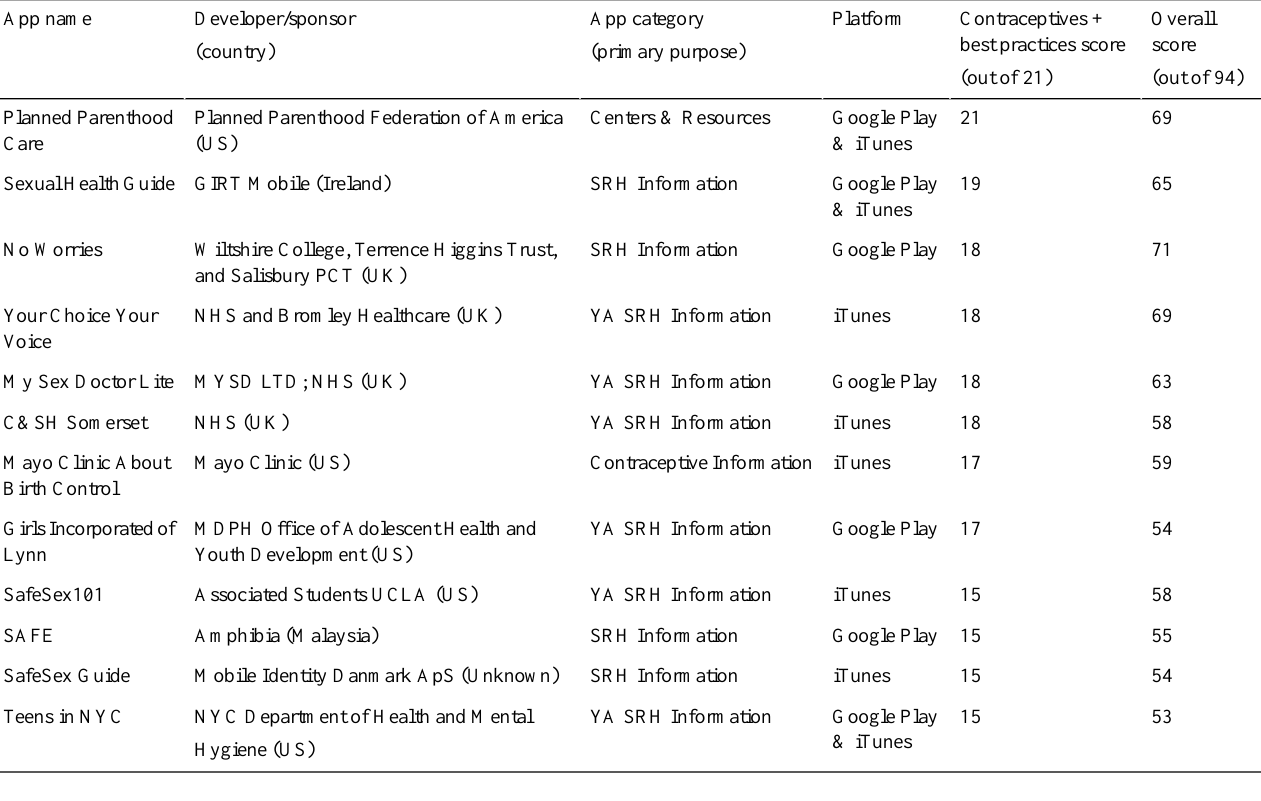
Table 2. Highest scoring apps overall and for contraceptive/best practices.